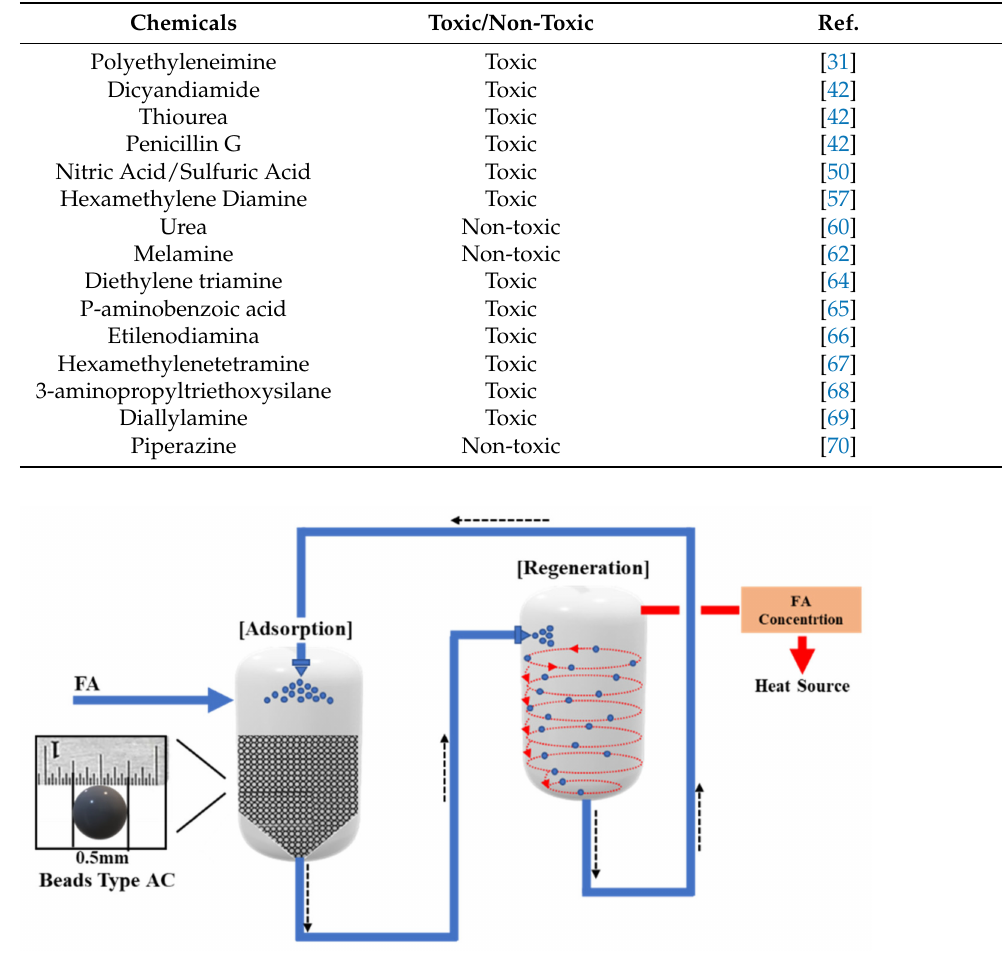
Figure 5. Conceptual diagram of recycling process for customized bead-type AC with 0.5 mm diameter, on